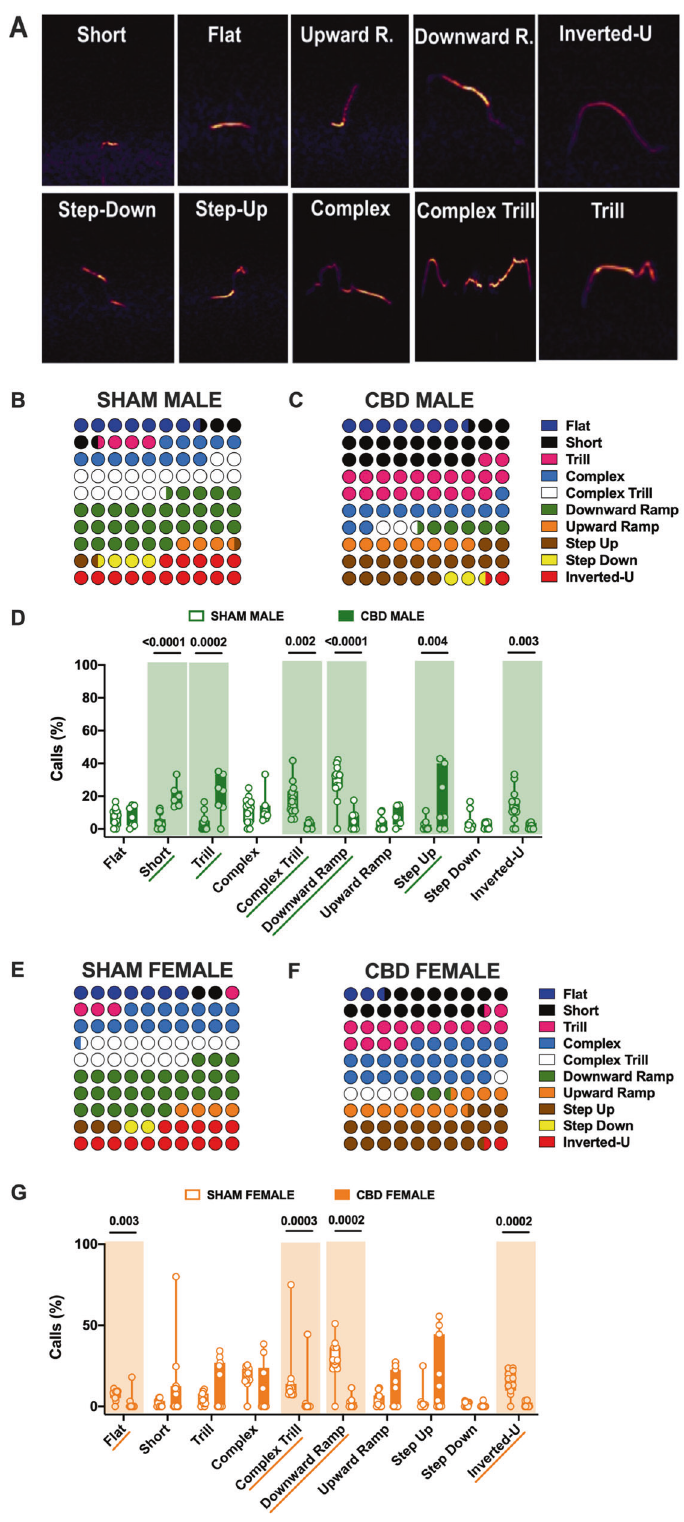
CBD males made shorter calls (Fig. 2E), whereas CBD females made more high frequency calls (Fig. 2F) than their SHAM counterparts. The probability distribution of USV frequency followed a bi-modal distribution in CBD-exposed males but not in females (Fig. 2G, H). Finally, a minor mode corresponding to high frequency calls was speci fi cally observed in CBD-exposed males (Fig.